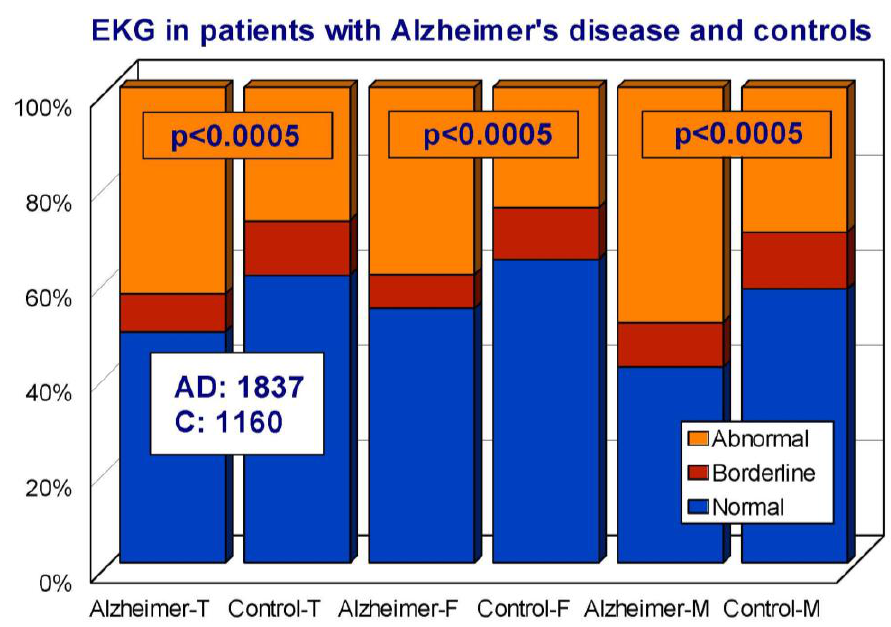
Figure 18. Electrocardiogram (EKG) in patients with Alzheimer’s disease and controls. T: Total; F: Females; M: Males.